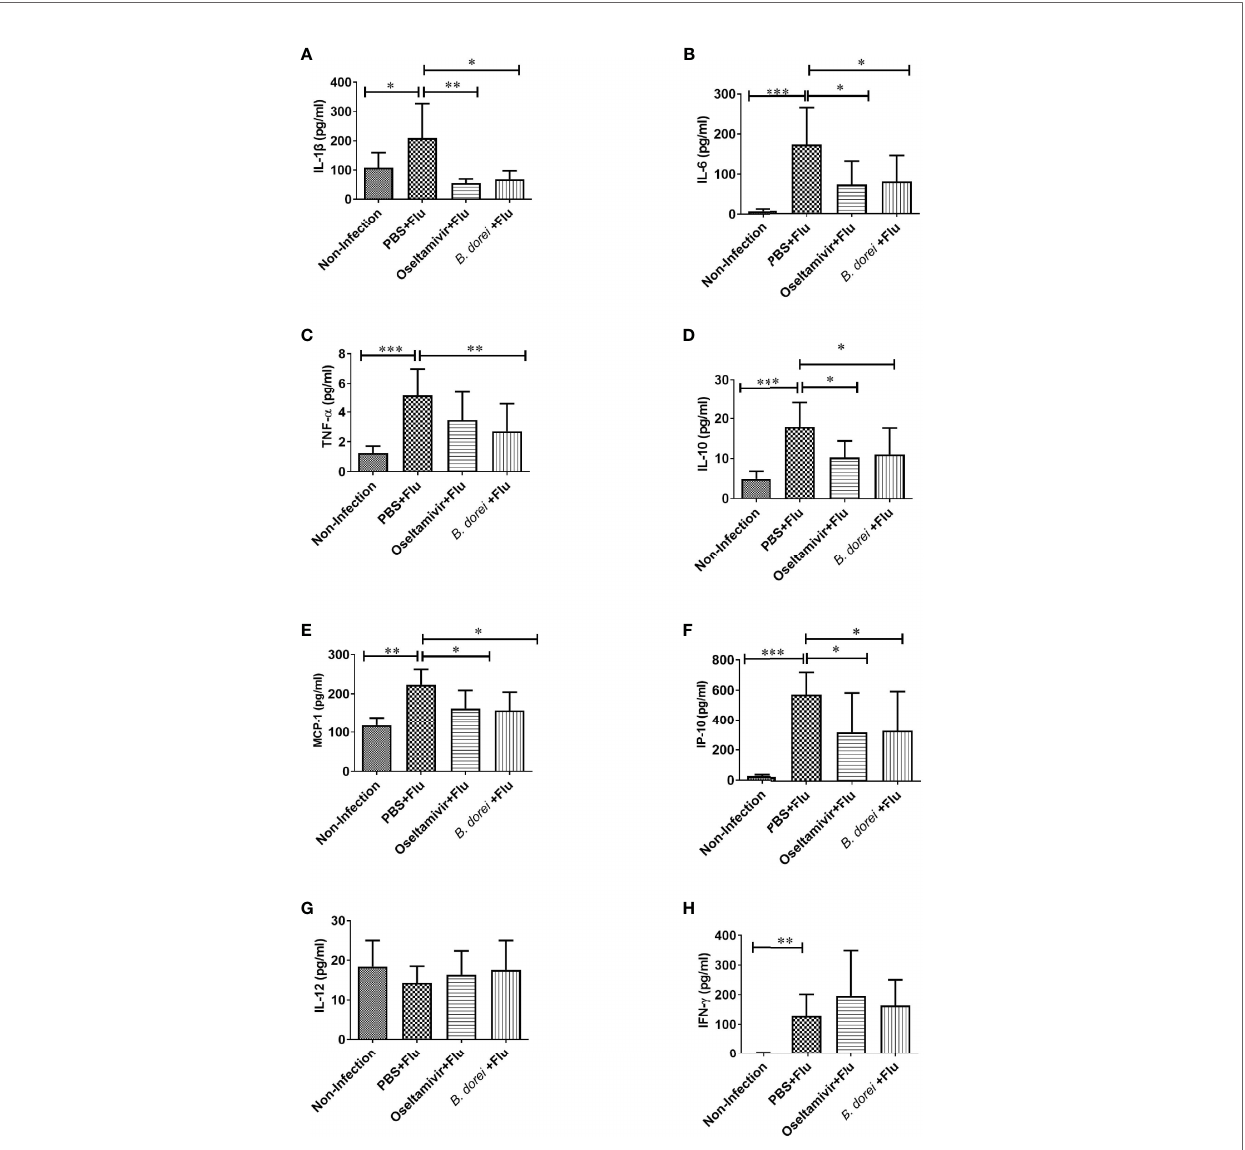
FIGURE 6 | Effects of B.dorei on serum cytokine pro fi les at day 7 post infection. The serum levels of cytokines and chemokines of the Non-Infection group, the PBS+Flu group, the B. dorei +Flu group and the oseltamivir+Flu group were compared and showed as follows: IL-1 b (A) , IL-6 (B) , TNF- a (C) , IL-10 (D) , MCP-1 (E) , IP-10 (F) , IL-12 (G) and IFN- g (H) . The data in panels (A – H) are shown as mean ± standard deviation from three independent experiments. *p < 0.05, **p < 0.01, ***p <